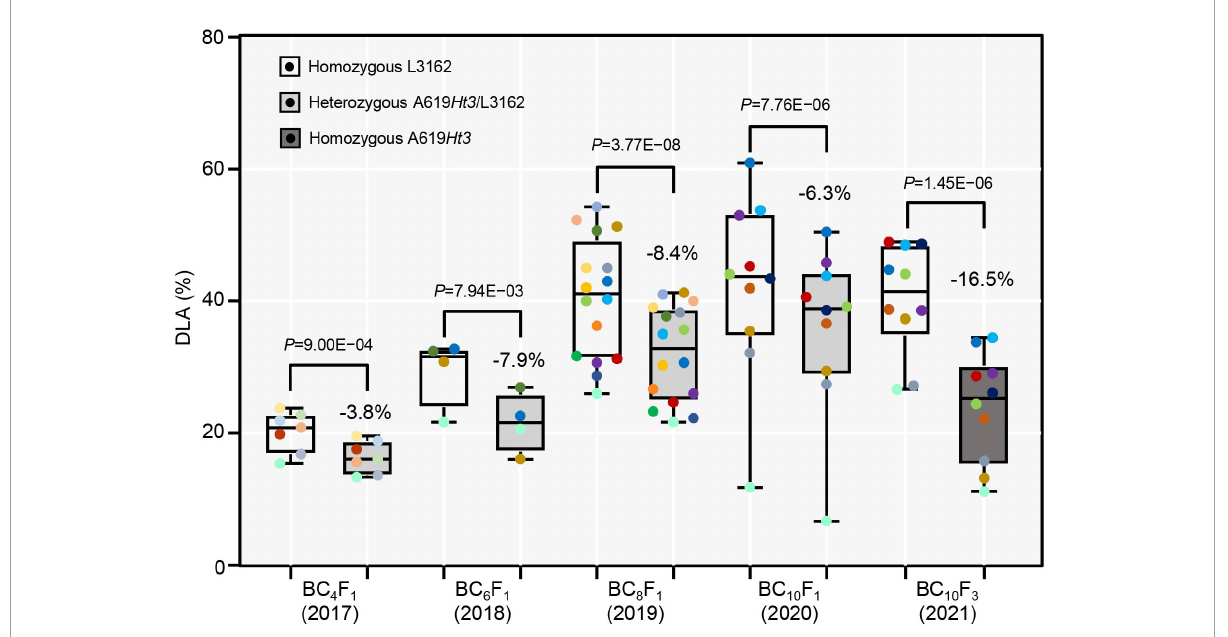
FIGURE4 The genetic effect of the Ht3L locus. The DLAs are shown for both homozygous and heterozygous genotypes at Ht3L in the BC 4 F 1 , BC 6 F 1 , BC 8 F 1 , BC 10 F 1 populations. The difference in DLA homozygous ht3l/ht3l and heterozygous Ht3L/ht3l genotypes was calculated for each generation. In the last two columns, the DLAs were calculated for two homozygous genotypes ht3l/ht3l and Ht3L/Ht3L of NIL-I and NIL-II. The P values between two genotypes were calculated by paired two-tailed t -test and indicated. P -value < 0.05 indicates significant difference; P -value > 0.05 indicates no significant difference.